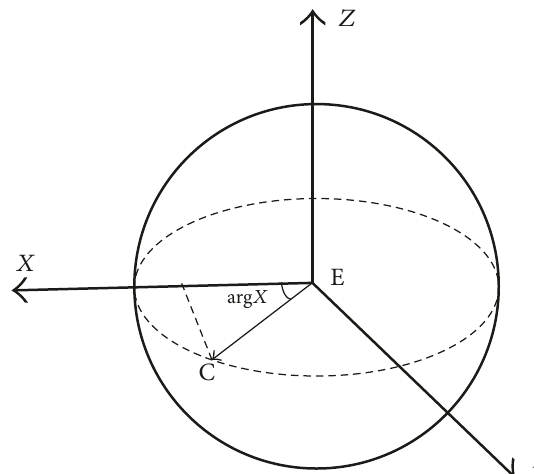
Figure 4: The geometrical relationship between the corneal apex and the eyeball center. Theoretically, x Similarly, the calculation equation could be acquired for y